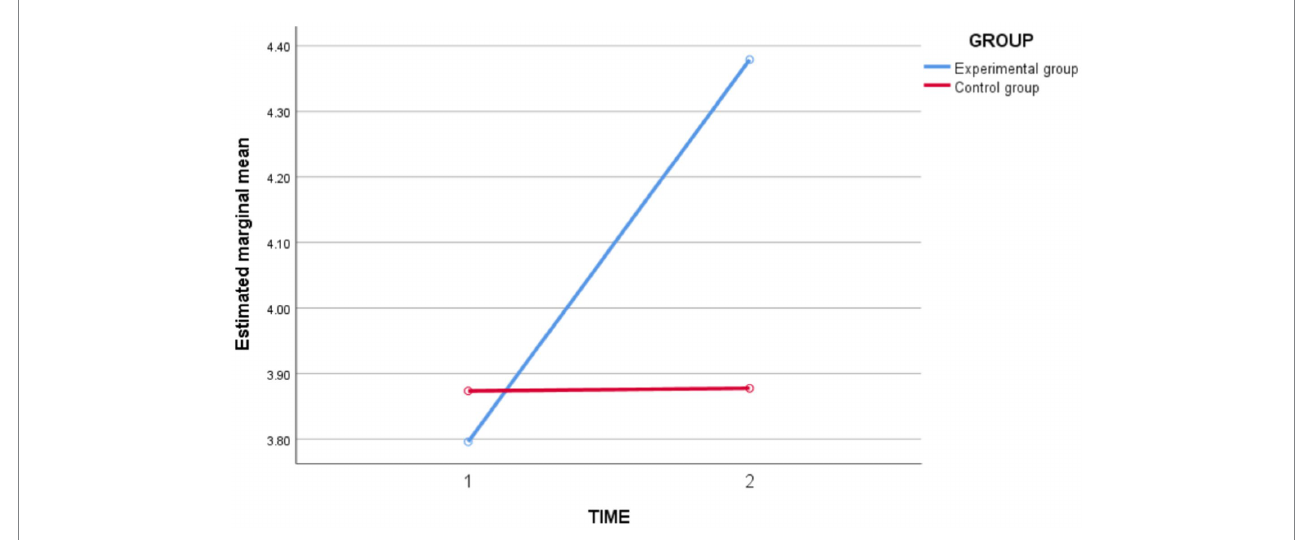
FIGURE 5 Schematic diagram of changes in self-regulated learning ability between the experimental group and the control group before and after the